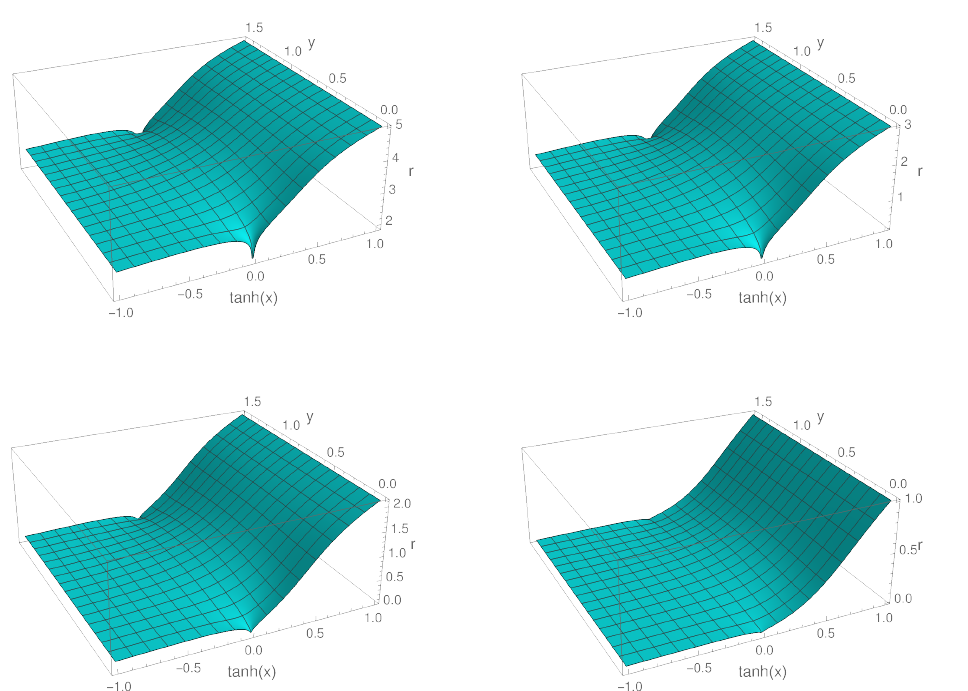
Figure 5 . Island surfaces from top left to bottom right anchored at r R ∈ { 5 , 3 , 2 . 1 , 1 } . The horizon is at r h = 0 and N 5 /K = 2 . The AdS 5 × S 5 region emerges at tanh x = 1 , the 5-brane sources are at tanh x = 0 and tanh x = − 1 is a regular point in the internal space. For smaller r R (smaller radiation region) the surfaces stay closer to the horizon. Near the 5-brane sources the surfaces reach to the horizon for all r R .